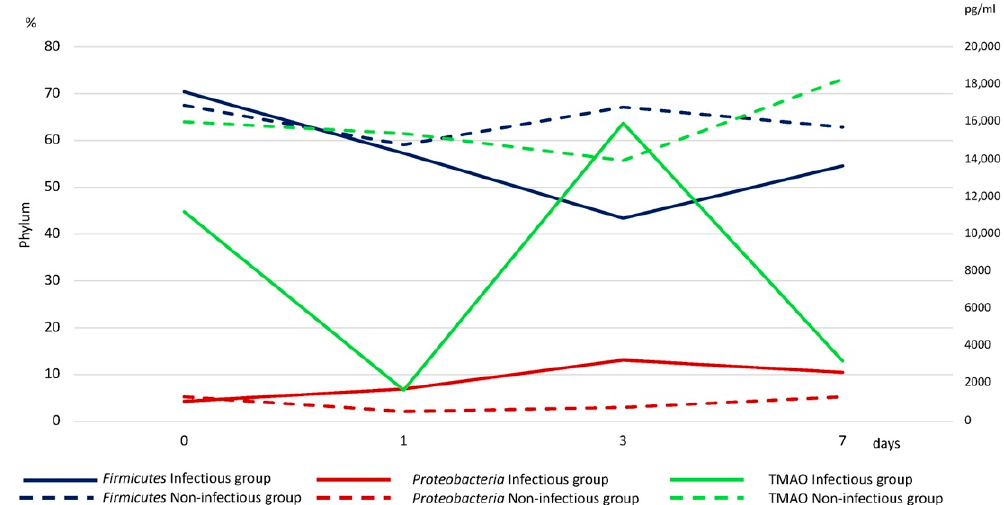
Figure 7. Association between metabolic activity of the gut microbiota by TMAO level (green line) and Phyla ( Firmicutes — dark blue line, Proteobacteria —red line). The group of infectious complications is shown by a solid line, and the group of non-infectious complications is shown by a dotted line.